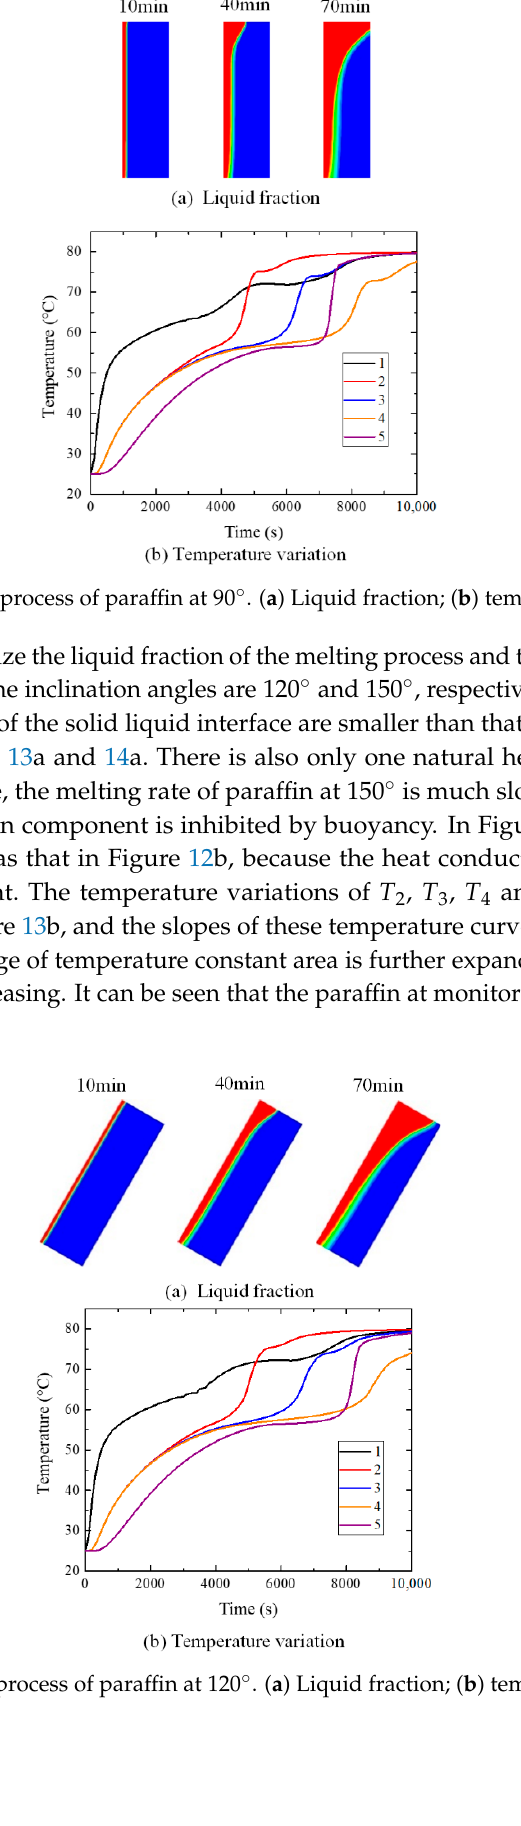
Figure 14. The melting process of paraffin at 150°. ( a ) Liquid fraction; ( b ) temperature variation.